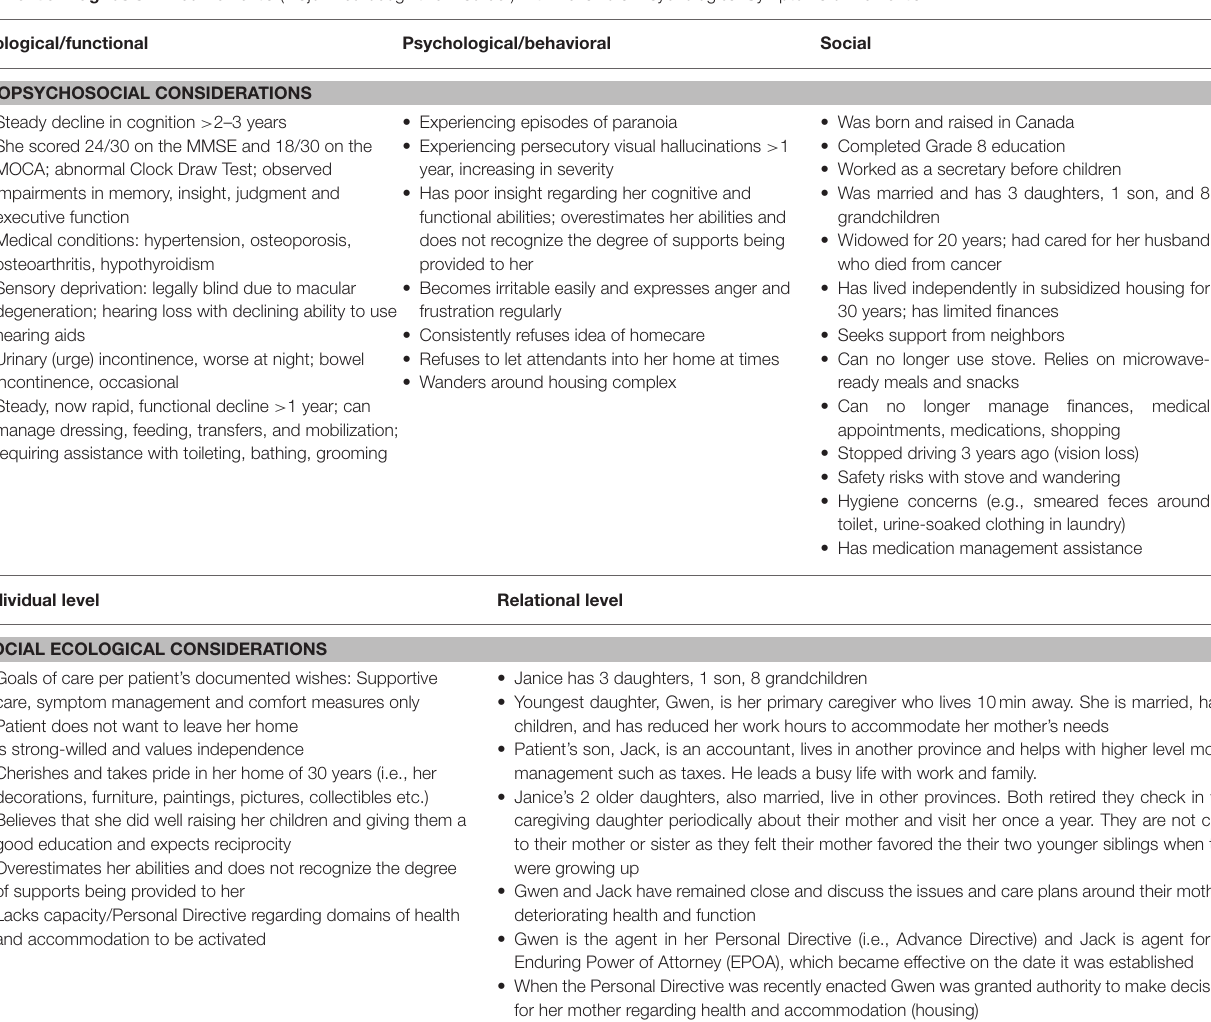
TABLE 1A | Examples of biopsychosocial and social ecological considerations for a person with dementia: the case of Janice. Identifying Information: Janice is an 85-year-old woman with advancing dementia who lives in Alberta, Canada Reason for Assessment: Dementia requiring support for care planning and medical intervention Dementia Diagnosis: Mixed Dementia (Major Neurocognitive Disorder) with Behavioral Psychological Symptoms of